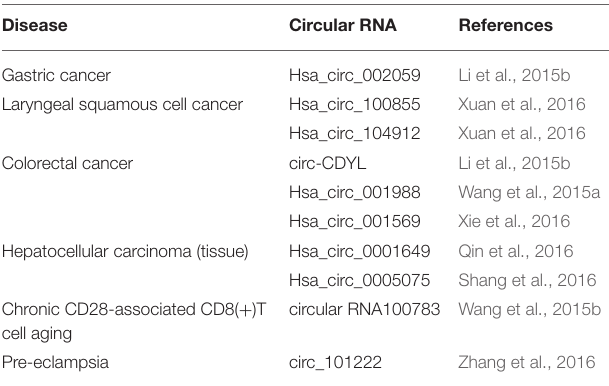
TABLE 1 | Circular RNAs that were reported to be potential biomarkers to detect specific diseases. Disease Circular